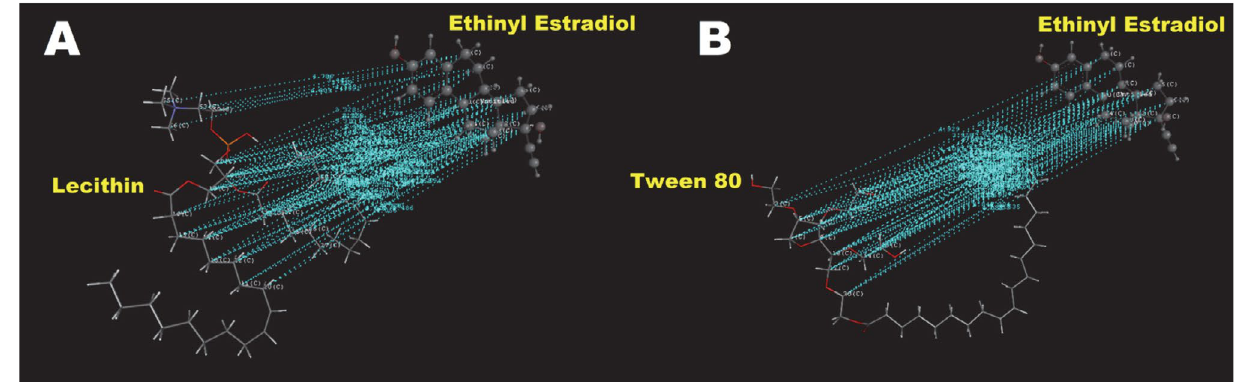
Figure 1. Docking study: a) interaction of ethinyl estradiol with soya lecithin, b) interaction of ethinyl estradiol with tween 80. *Colour code Light blue: Vander Waal interaction, Green: Hydrogen